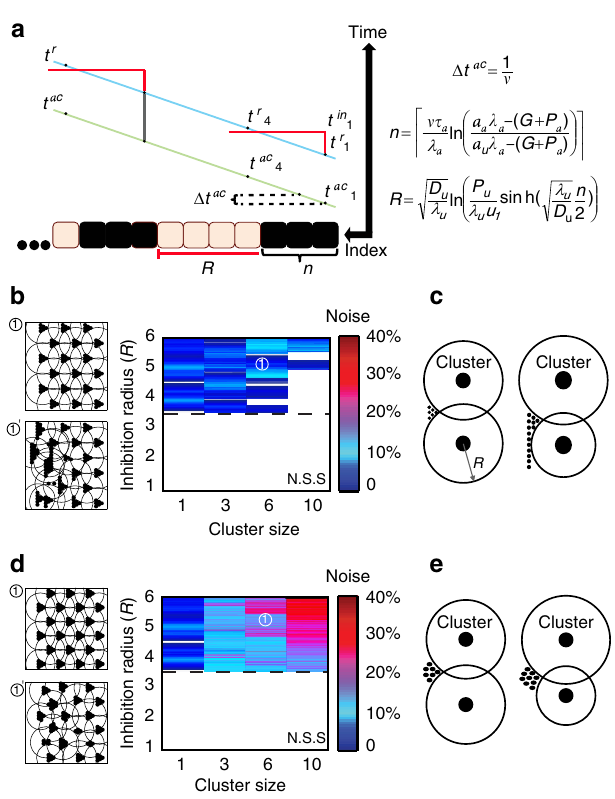
Figure 2 | Incompatibility of linear activation propagation and radial inhibition. ( a ) Pattern formation in one dimension. Time is on the vertical axis and cell position on the horizontal axis. Cluster size is defined by the number of cells that become refractory before the first cell in the cluster produces inhibition (red horizontal line). t ac is the time when cell i receives i sufficient h to induce a expression, provided that it was not yet inhibited. t r i is the time when an activated cell becomes refractory. t in is the time when i an activated cell begins secreting the inhibitor u . D t ac is the time gap between activation of two adjacent cells. n is the size of the cluster. R is the distance between clusters. The dependence of those times on the model parameters is derived in Supplementary Note 2. ( b ) Shown is the noise sensitivity of the simplified model in two dimensions for different values of inhibition radii and cluster sizes. Simulations were performed on a grid by sequentially selecting clusters of the desired size and drawing inhibition radii around them. Noise sensitivity was defined by the maximal noise level that can be introduced before pattern failure, for optimized initial conditions as we did in Fig. 1c. Noise was introduced by selecting each inhibition radius from a uniform distribution that was centred at the indicated values R and whose width was R (cid:4) ~ n , ~ n defining the noise level. A pattern of cluster size 1 was considered destroyed when a cluster of size larger than 3 was formed. Similarly, a cluster of 3, 6 and 10 was considered destroyed when clusters of 6, 10 and 15 formed, respectively. All simulations were run until cell differentiation reached the end of the grid. N.S.S. stands for non-sufficient spacing as in Fig. 1d. ( c ) Selection of a long, uninhibited cell line (catastrophe) is the main source of noise sensitivity. See Supplementary Fig. 2 for more details. ( d ) Same as ( b ) for the extended model including an activator. In addition to adding noise to the inhibition radii, noise was added to the activation radii in a similar manner. Pattern failure was determined as in b . ( e ) Since cluster size is now defined by the short-range activator, rather than propagation of h , sensitivity to catastrophes is